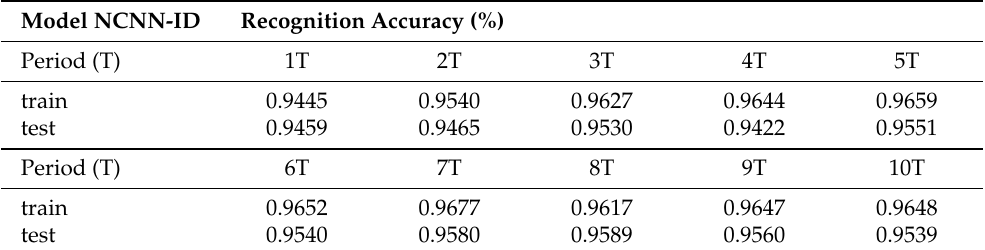
Table 6. Experimental results under different timing widths of NCNN-1D